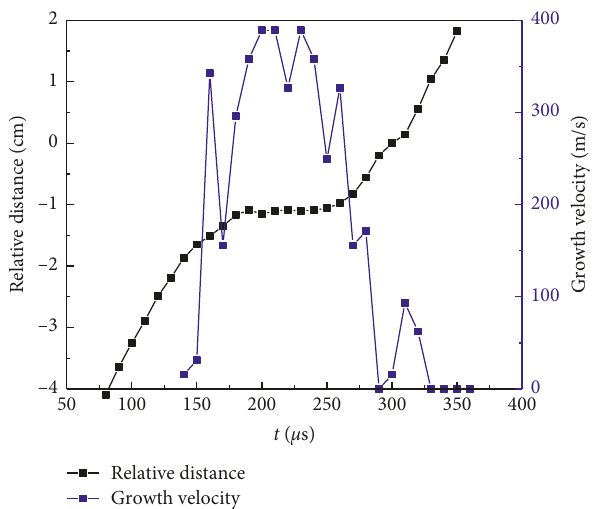
Figure 5: Velocity curve of the original crack growth and the relative displacement curves of the arc wave and the growing crack